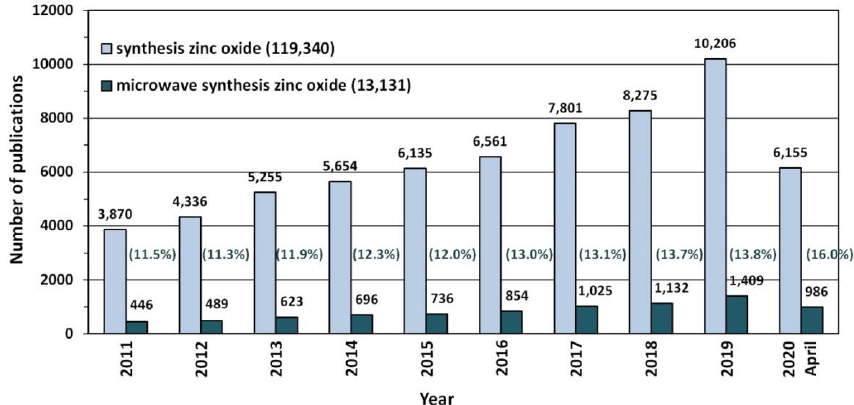
Figure 6. The number of scientific publications referring to the search of “synthesis zinc oxide” and